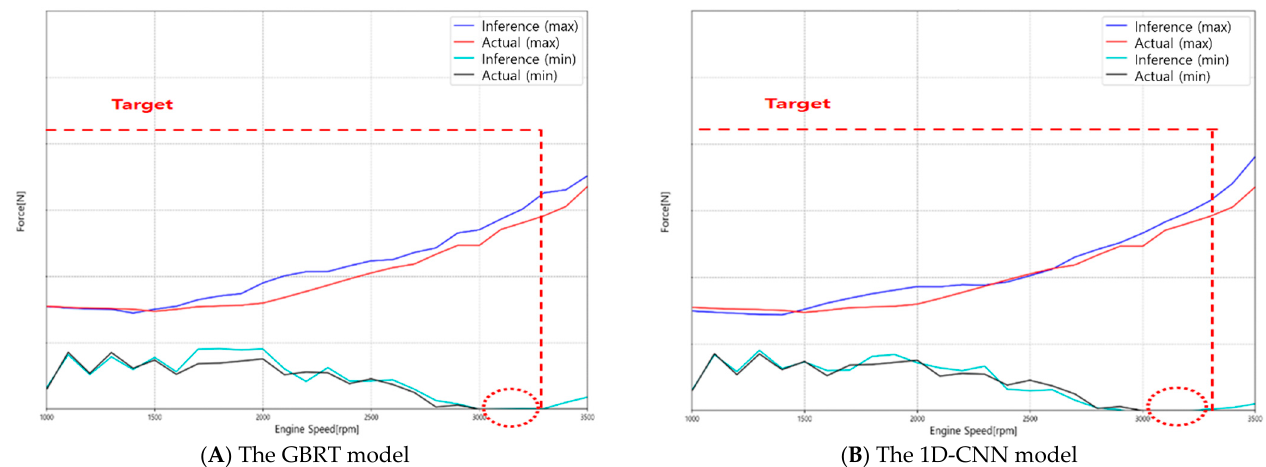
Figure A2. Comparing the predicted values of the valve seating velocity based on the crank angle.